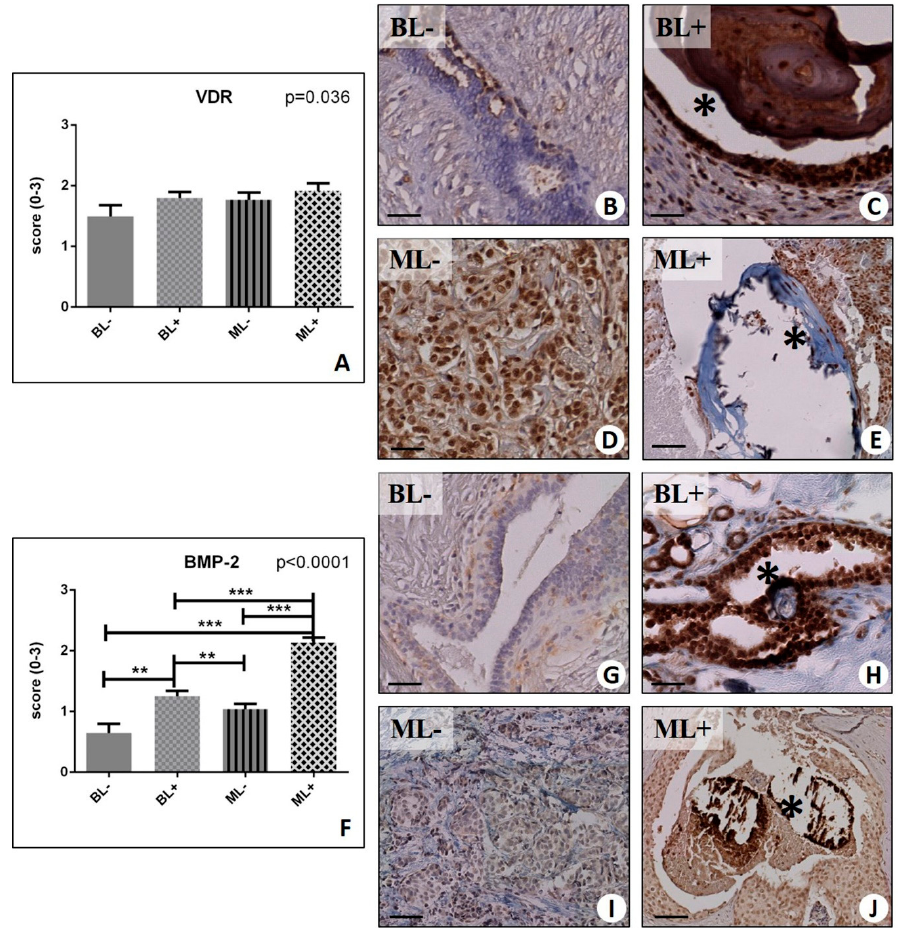
Figure 3. Immunohistochemical evaluation of Vitamin D Receptor (VDR) and Bone